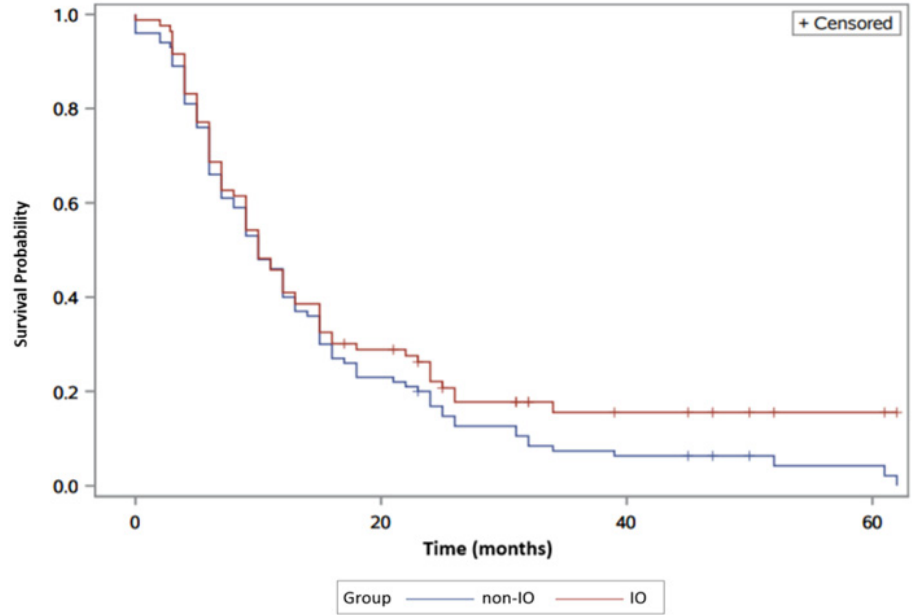
Figure 2. Overall survival in IO versus non-IO patients. The blue line represents the non-IO whereas the red line represents the IO population.